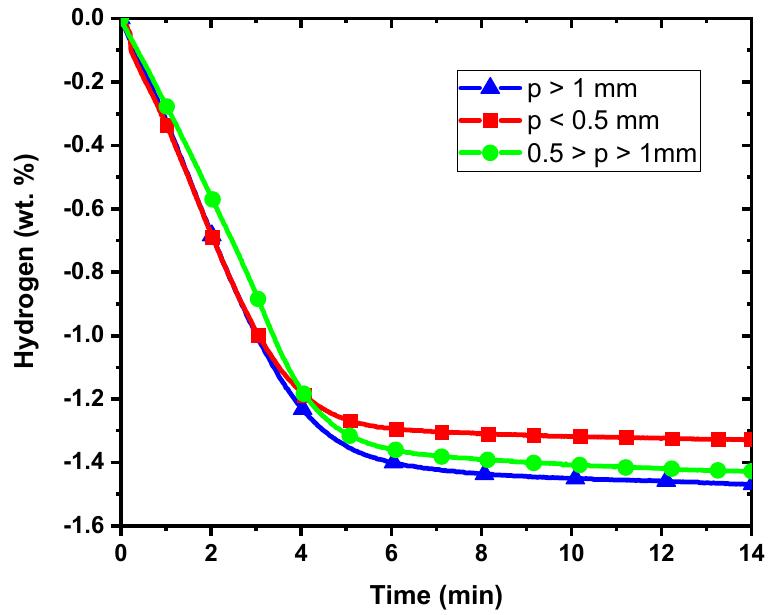
Figure 3. First dehydrogenation at room temperature under partial vacuum of as-cast alloy with different particle sizes.